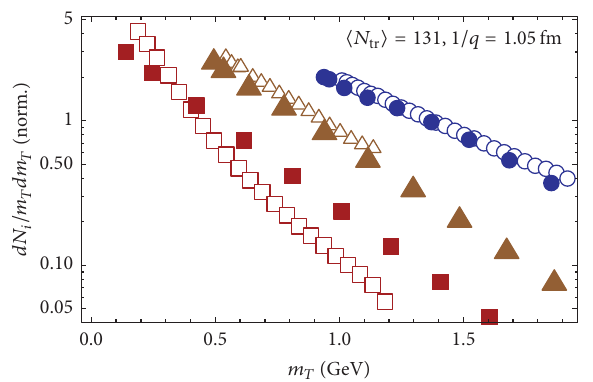
Figure 7: Normalized spectra of pions (squares), kaons (triangles), and protons (discs) for p-p collisions. Open symbols correspond to the CMS data [194] for |𝜂| < 2.4 and √𝑠 = 7 TeV, while the solid ones are obtained from the best one-parameter fit of Gubser’s flow.